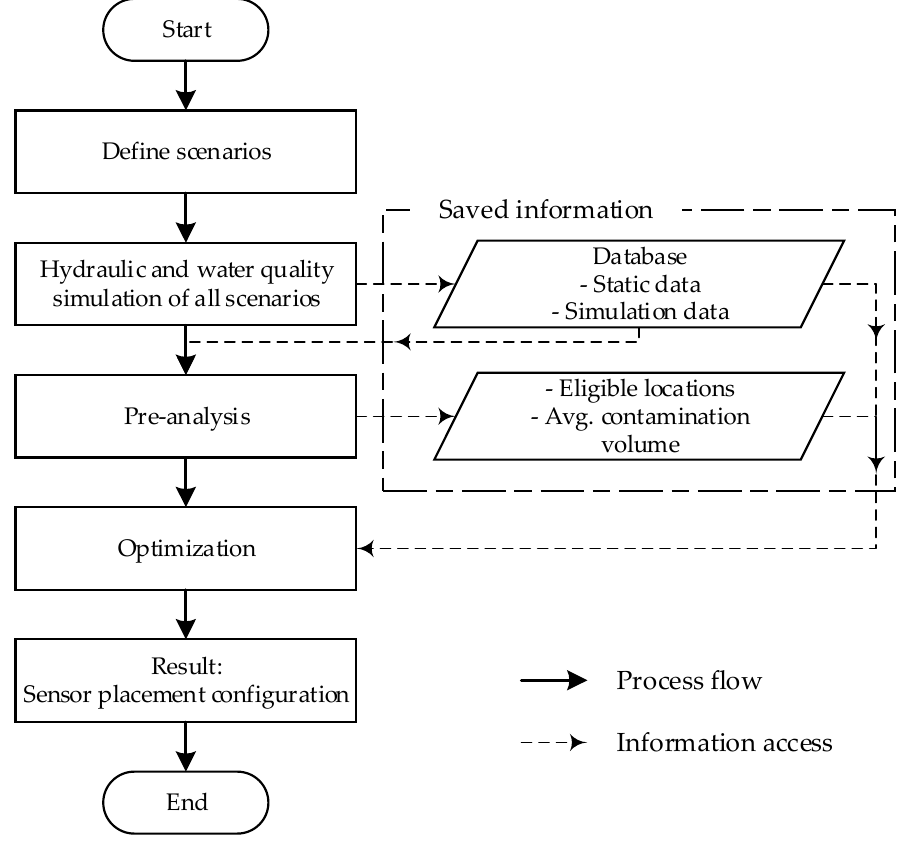
Figure 1. Methodology flowchart.